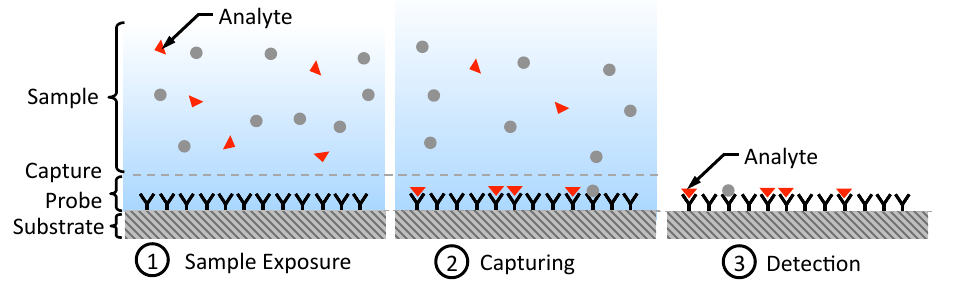
Figure 1. Steps in affinity-based